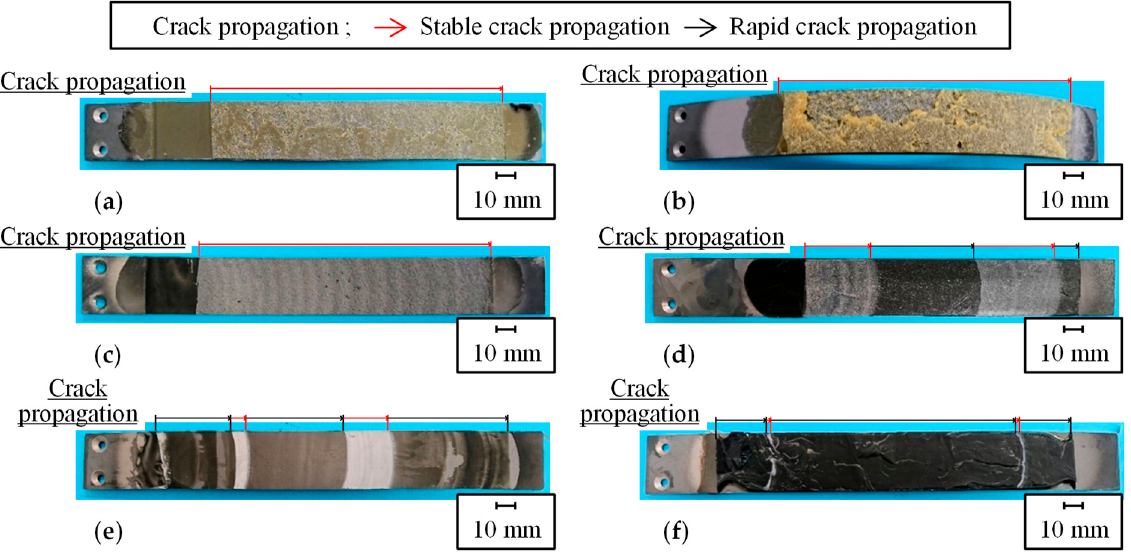
Figure 8. Fracture surfaces of the DCB specimen of ( a ) 0.3 mm thickness of Y618H, ( b ) 3.0 mm thick- ness of Y618H, ( c ) 0.3 mm thickness of Metal Lock, ( d ) 3.0 mm thickness of Metal Lock, ( e ) 0.3 mm thickness of Y611 Black S, and ( f ) 3.0 mm thickness of Y611 Black S.